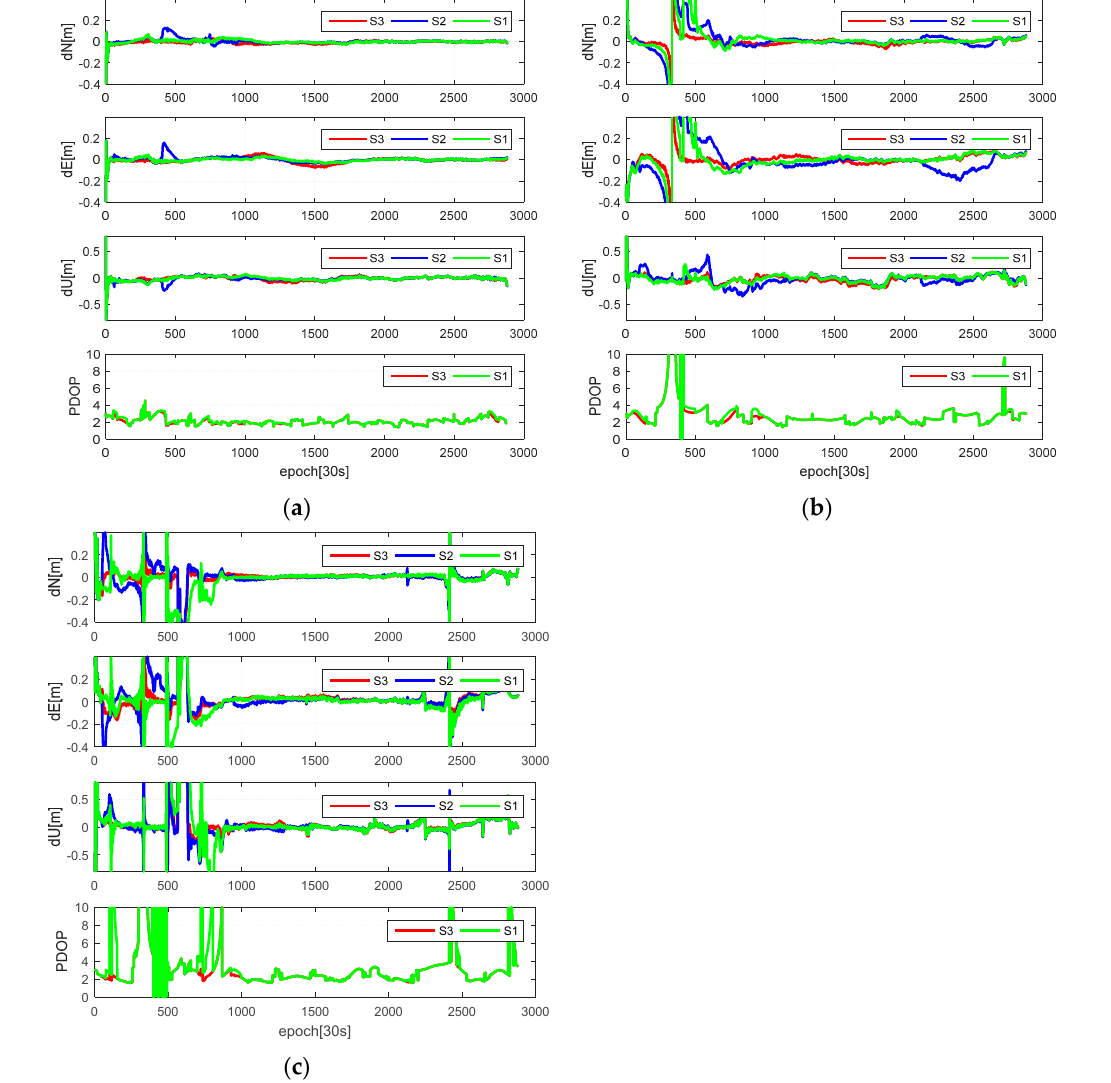
Figure 13. The positioning performance of GLONASS-only kinematic PPP for three eclipsing strategies: ( a ) station RGDG; ( b ) station MGUE; and ( c ) station AREG (DOY 194 of 2017, the sampling rate is 30 s).